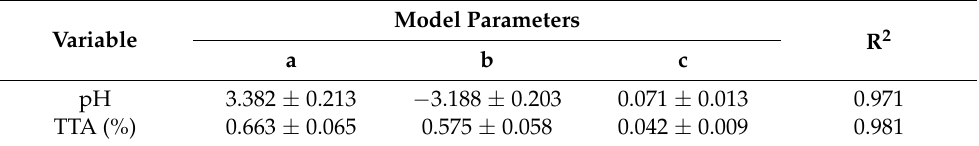
Table 2. Exponential model parameters for the kinetics of pH and TTA of millet slurry during fermentation *.